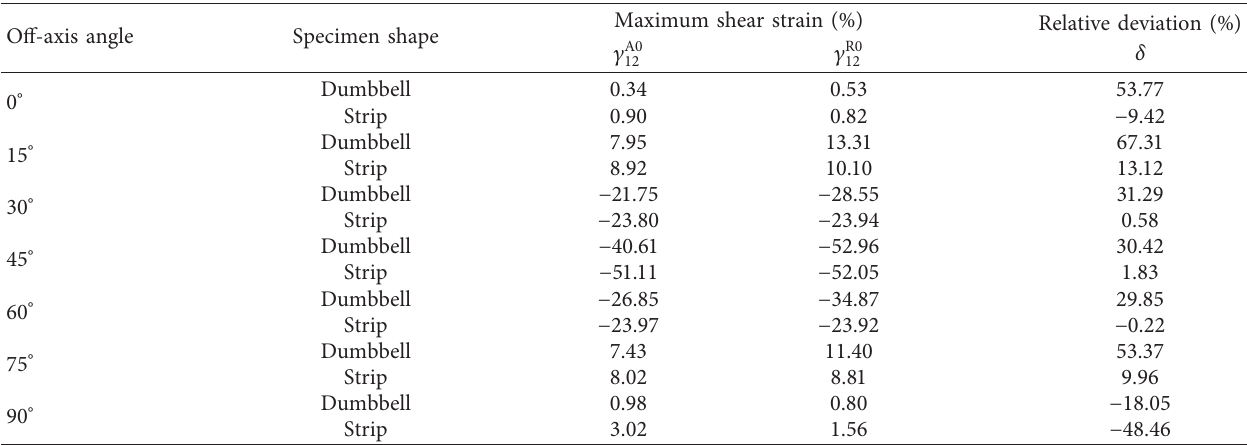
Figure 8: Variation in maximum shear strain with respect to the off-axis angle. (a) Dumbbell shape. (b) Strip shape. Table 2: Results of the maximum shear strain.